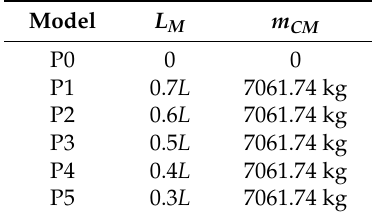
Table 3. Mooring system model